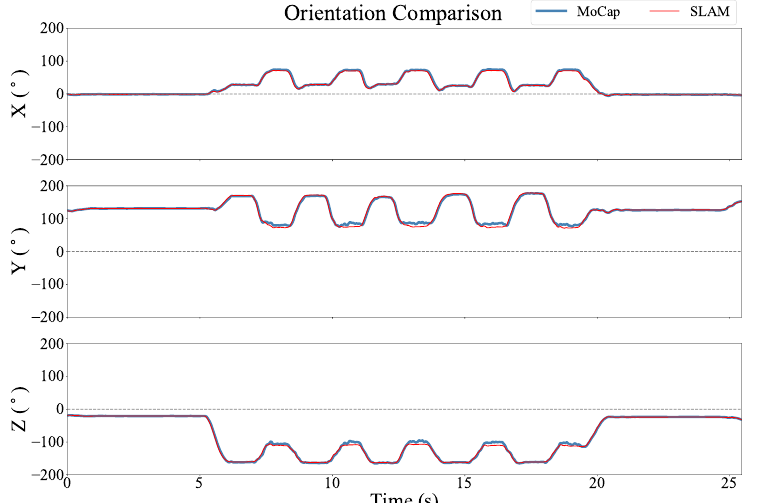
Figure 6. Euler angles versus time for each axis in the Optical Motion Analysis Lab coordinate frame.